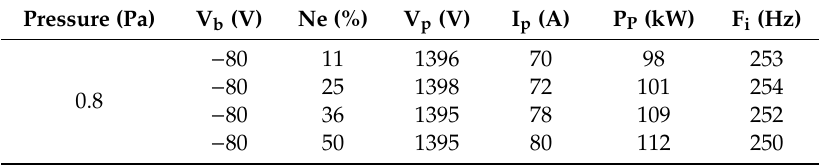
Table 2. Experimental parameters used for the deposition of DLC films in Ar + Ne plasma. Pressure